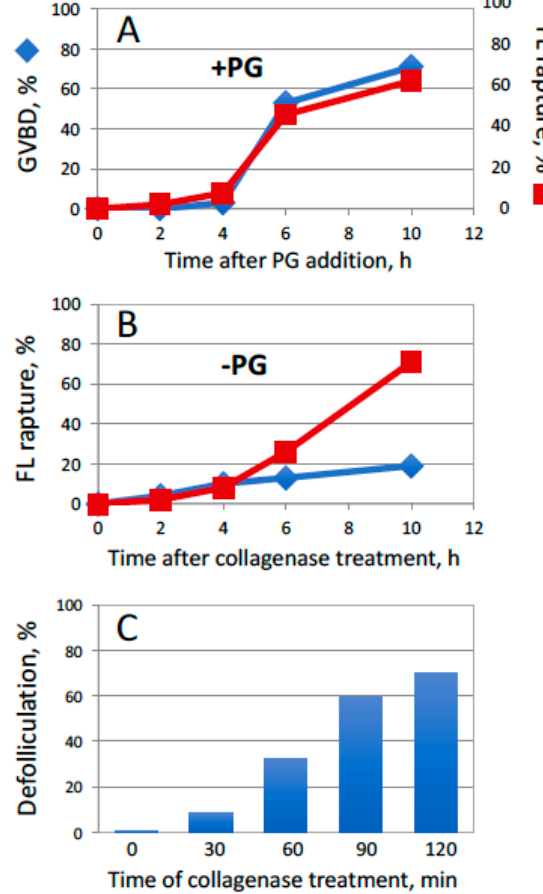
Figure 3. Effects of PG on the follicular oocytes pretreated with collagenase. Isolated follicles were pretreated with 5 mg/mL collagenase for 30 min before PG administration. ( A ) Time courses of GVBD and follicle rupture in the PG-treated oocytes; ( B ) time courses of spontaneous hormone-independent defolliculation in the follicles pretreated with collagenase for 30 min (blue color) or 120 min (red color); ( C ) time dependency of defolliculation in the presence of 5 mg/mL collagenase. The experiment was repeated with five batches of follicular oocytes obtained from different animals, and the results of a single batch experiment are presented.